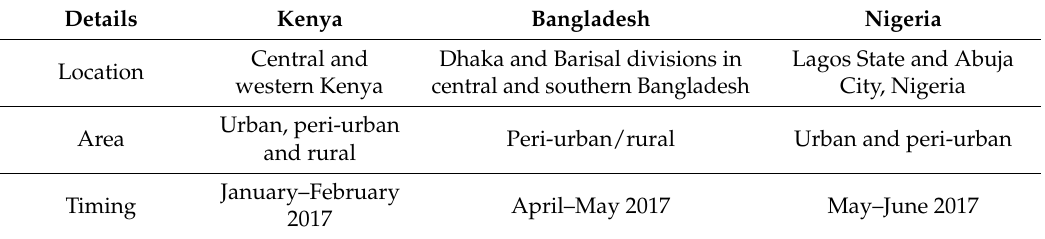
Table 1. Overview of behavior change communications (BCC) baselines.